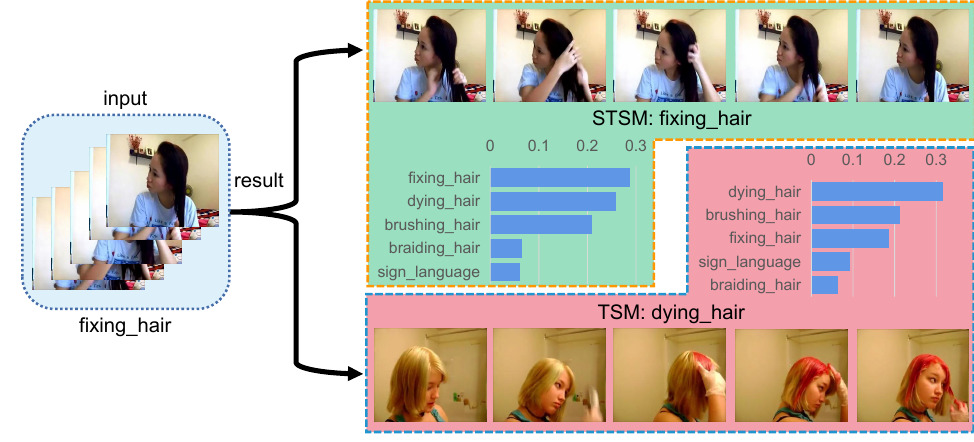
Figure 5. The top five results of STSM and TSM of the fixing hair sample.